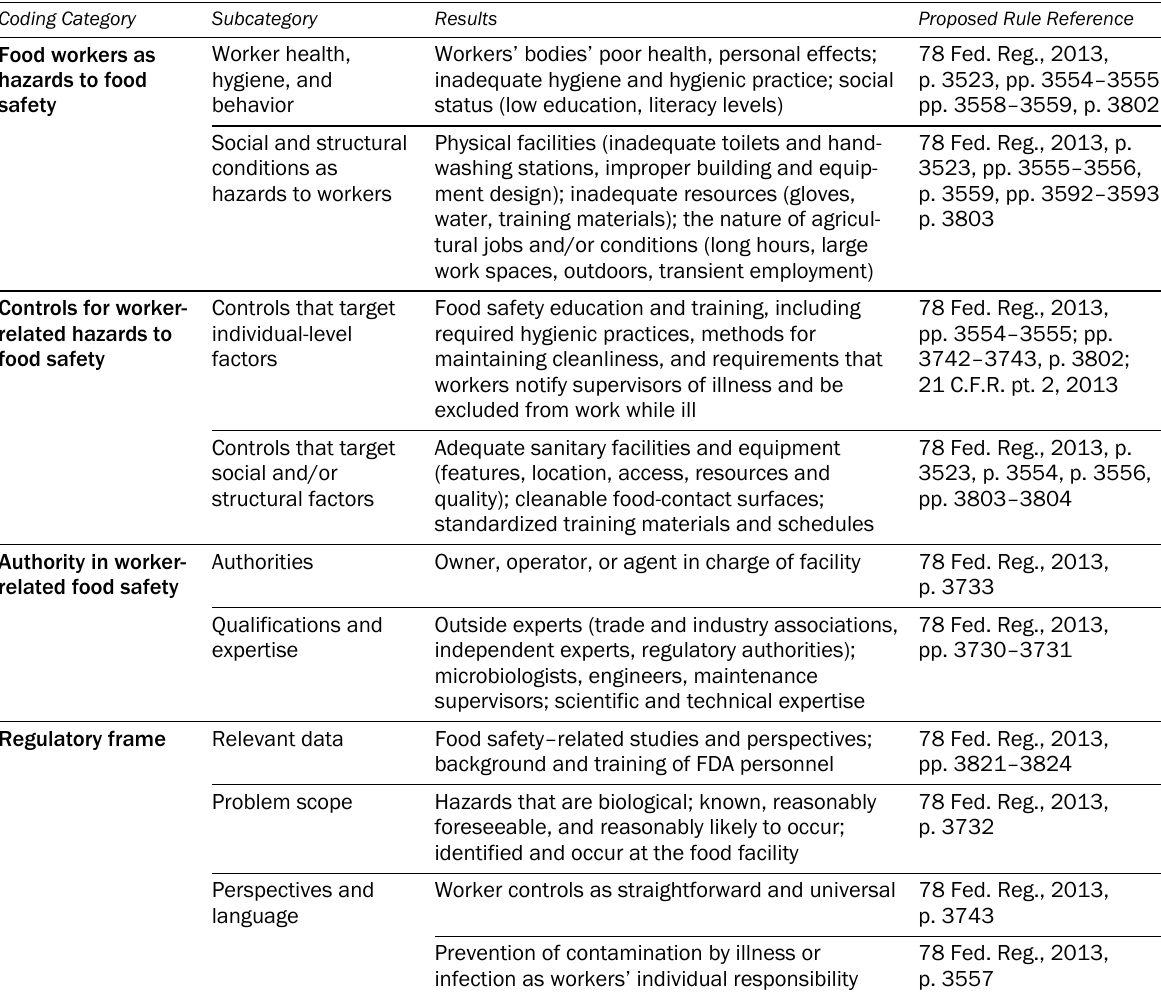
Table 2. Results by Coding Category and Proposed Rule Section Coding